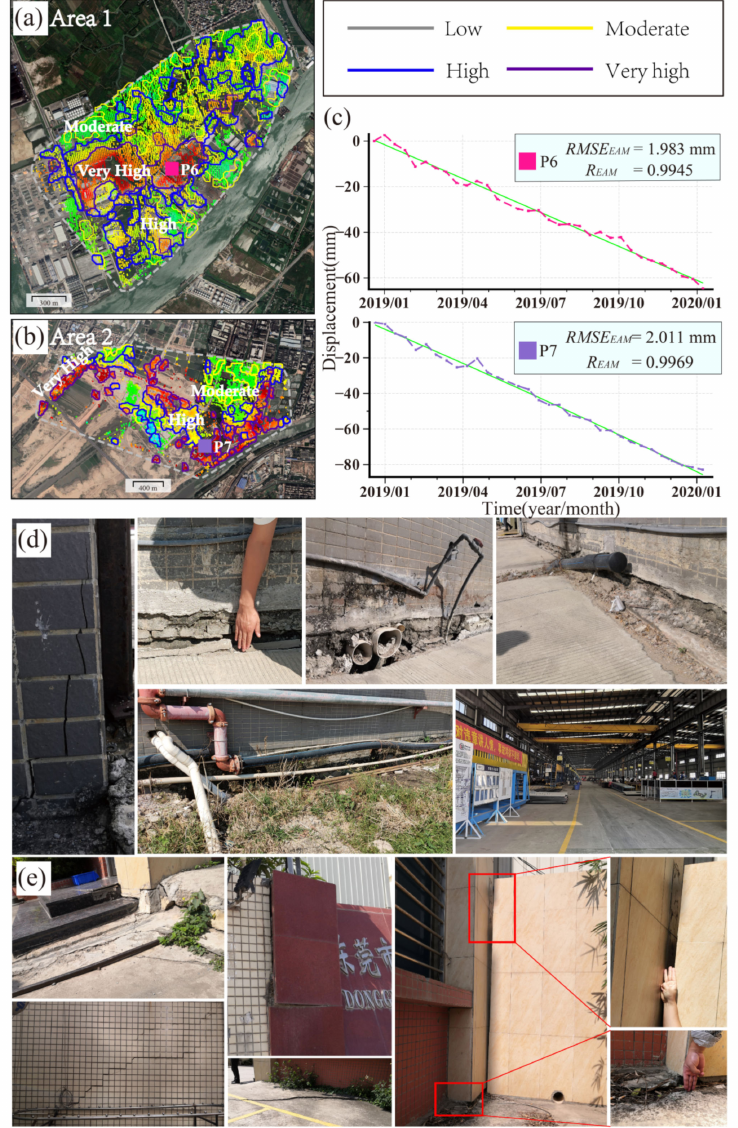
Figure 12. Some high instability regions in Dongguan City identified by the improved method. The areas marked in Figure 11b,c. ( a , b ) are the maps of the deformation velocity and instability refinement of the points in the two field investigation areas. ( c ) is the time series of P6, P7 ( d ), and ( e ) are photos of the cracks recognized during the field